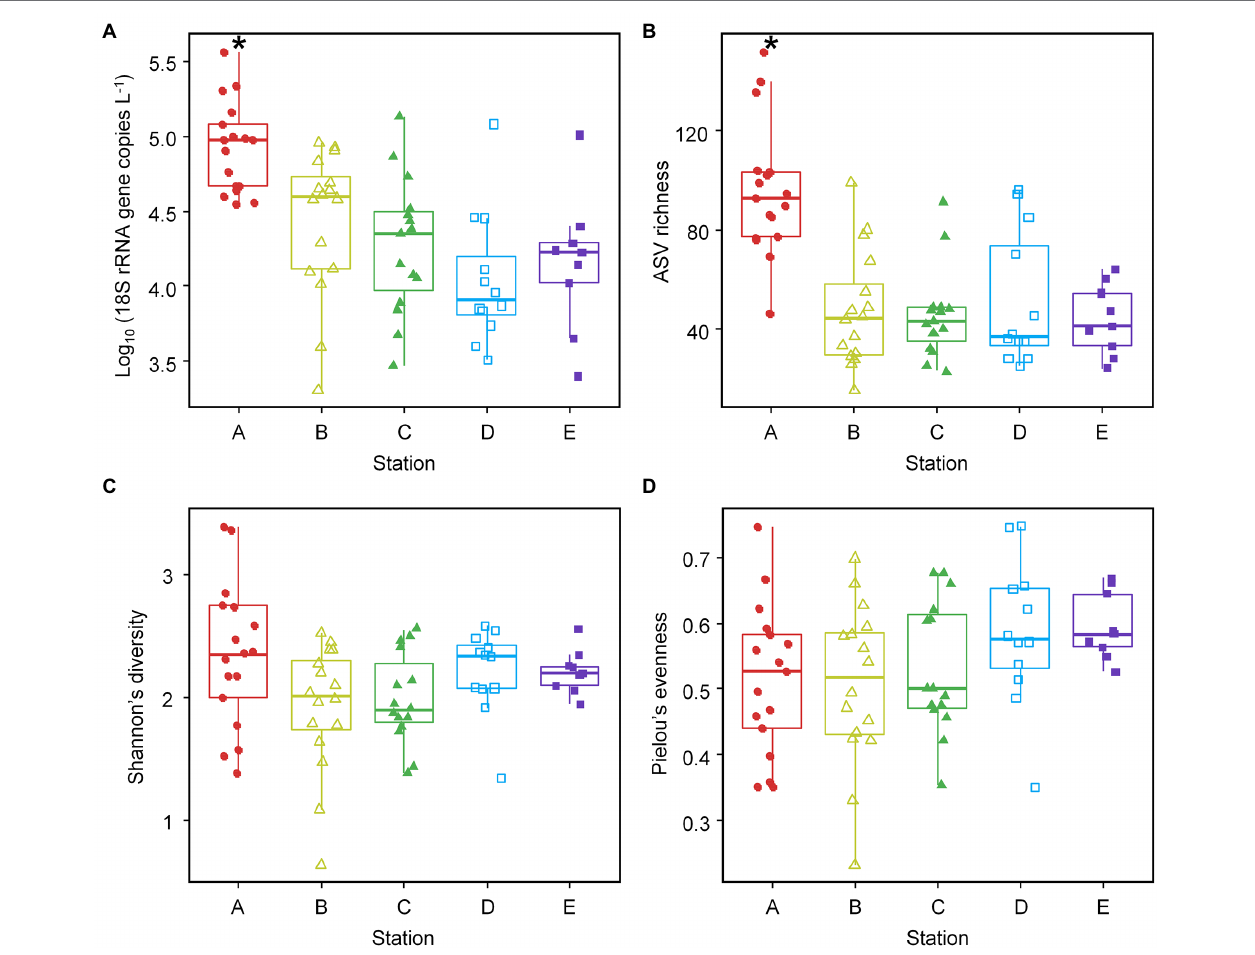
FIGURE 2 | Total abundance of the Labyrinthulomycete 18S rRNA genes (A) and their ASV richness (B) , Shannon’s diversity (C) , and Pielou’s evenness (D) across the nearshore-to-offshore stations (stations A–E). The box for each sampling site represents the 25th and 75th percentiles of its temporal variation; the horizontal line within the box represents the median value; the whiskers represent the lowest and highest values (excluding the outliers); the jittered shapes represent individual sample values. The asterisks above the boxes for the abundance and richness at the nearshore station A indicate statistically higher values than those at the other four stations (ANOVA, p <